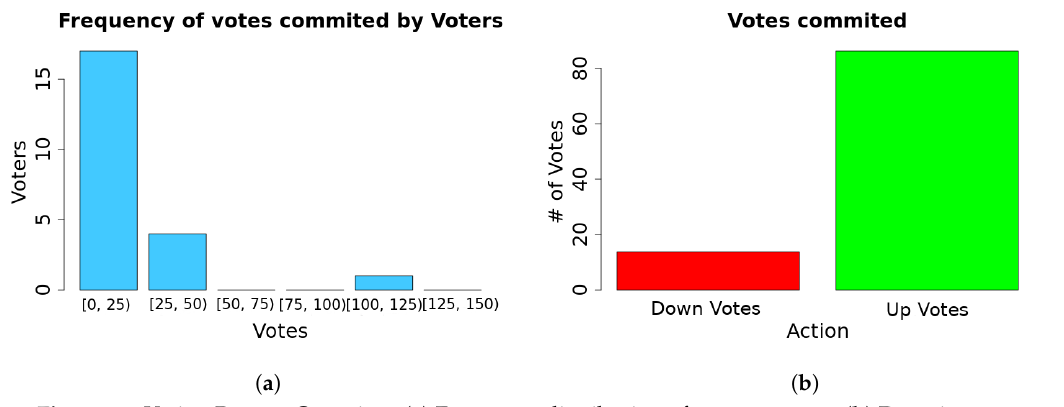
Figure 13. Voting Process Overview. ( a ) Frequency distribution of votes per user; ( b ) Domain experts found that 13% of the links presented to them where